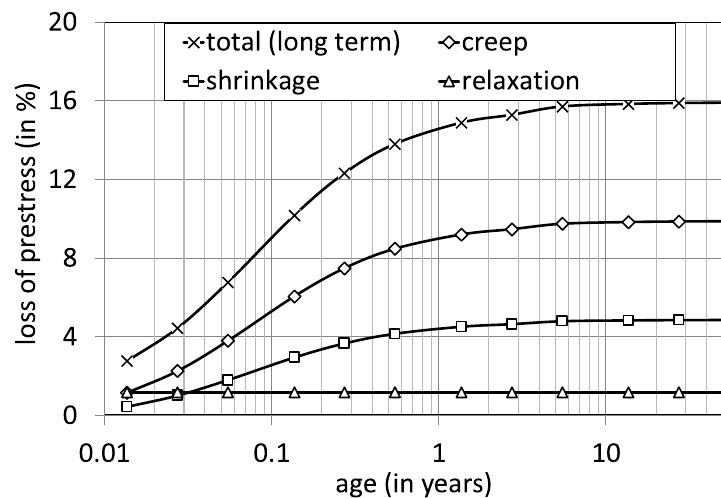
Fig. 2 Variation of prestress loss with age for PSC girder (using AASHTO LRFD